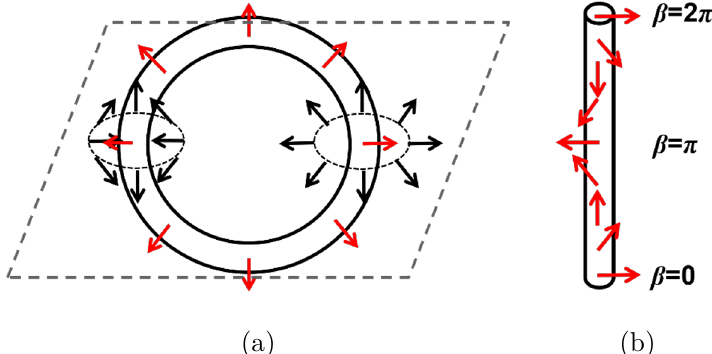
Figure 2 . A monopoles as a twisted Alice string. (a) an isolated monopole as a twisted Alice ring along which the U(1) modulus is twisted once. (b) a monopole on a straight Alice string along which the U(1) modulus is twisted